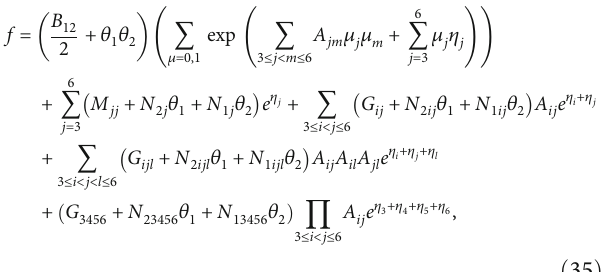
Figure 6, a 4-soliton solution exhibits the interaction between two line solitons and one lump under the longwave limits with the parameter selection of l 1 = l ∗ 2 = 3 : 5 + i , k 3 = 0 : 5 , k 4 = 0 : 8 , l = 0 : 5 , l = 0 : 75 , and β = β = 0 in (33). At fi rst, they 3 4 3 4